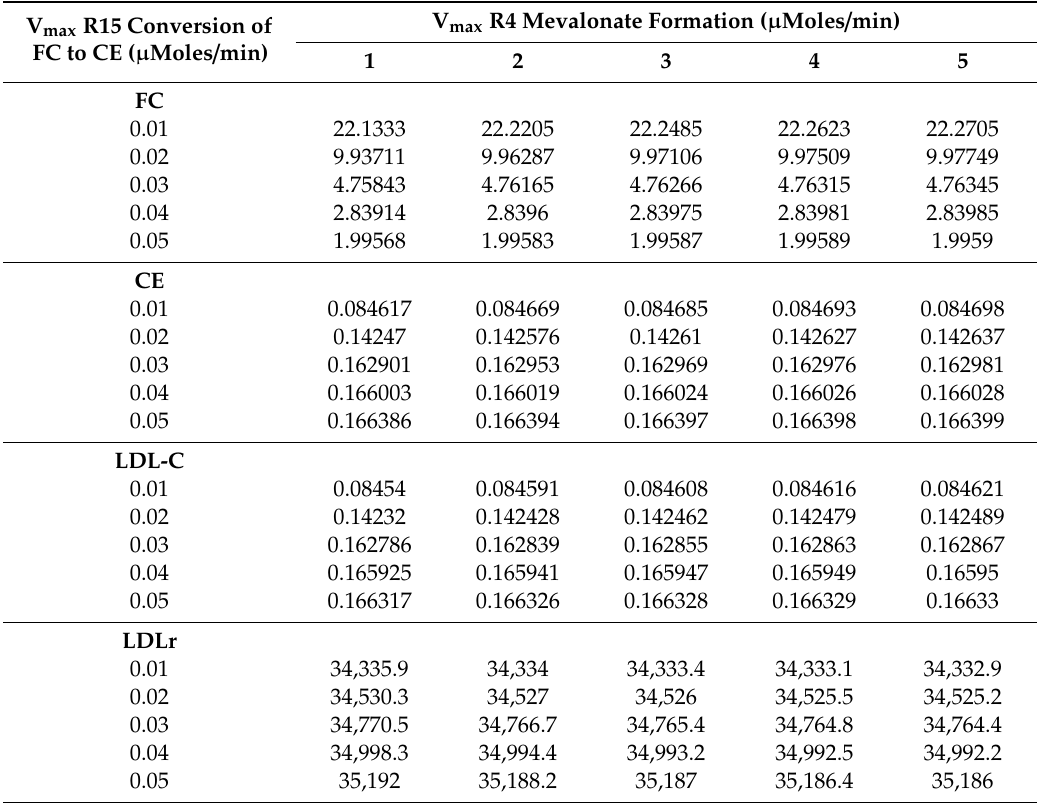
Table 2. The E ff ect of combined HMGCR and ACAT2 modulation on FC, CE, LDL-C and LDLr. V max R15 Conversion of FC to CE ( µ Moles /